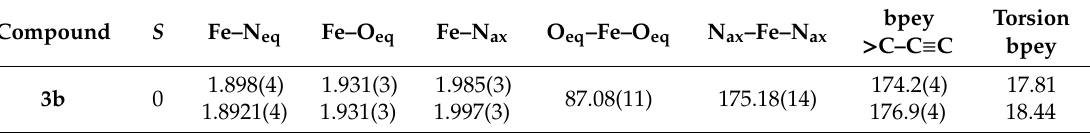
Table 2. Spin state, selected bond lengths / Å, and angles / ◦ within the inner coordination sphere of 3b , and angles and torsion angles of